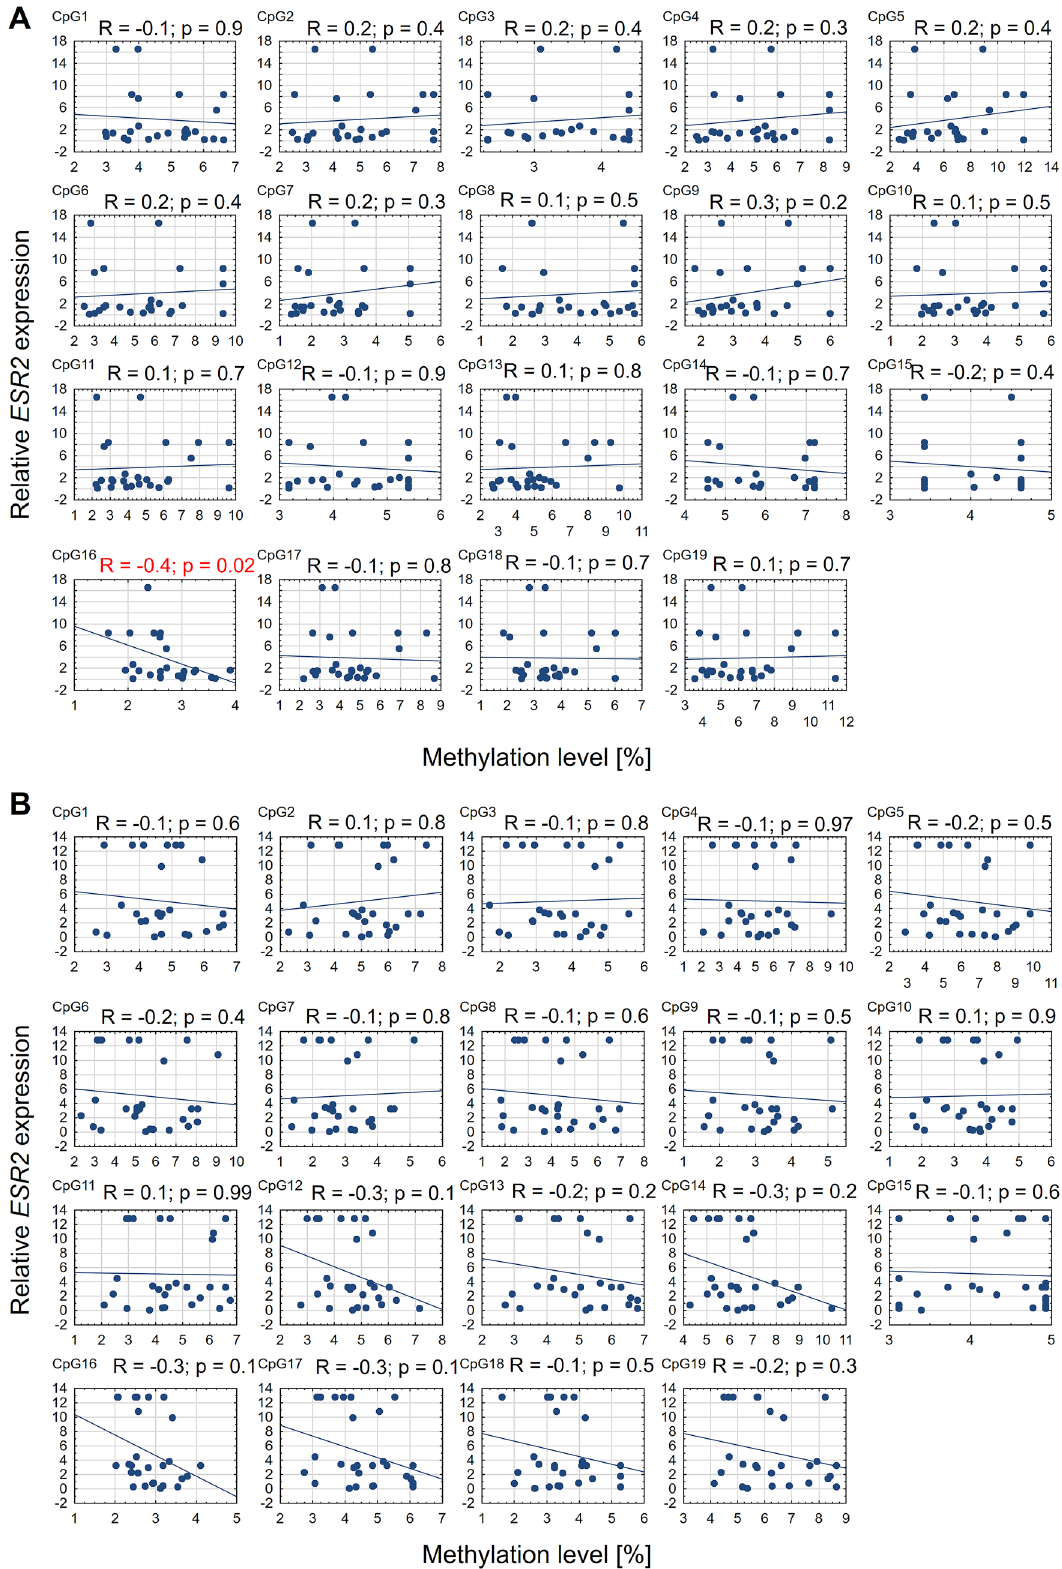
Figure 5. Correlation between ESR2 expression and methylation level at each CpG site in exon 0N on the convex ( A ) and concave ( B ) side of the